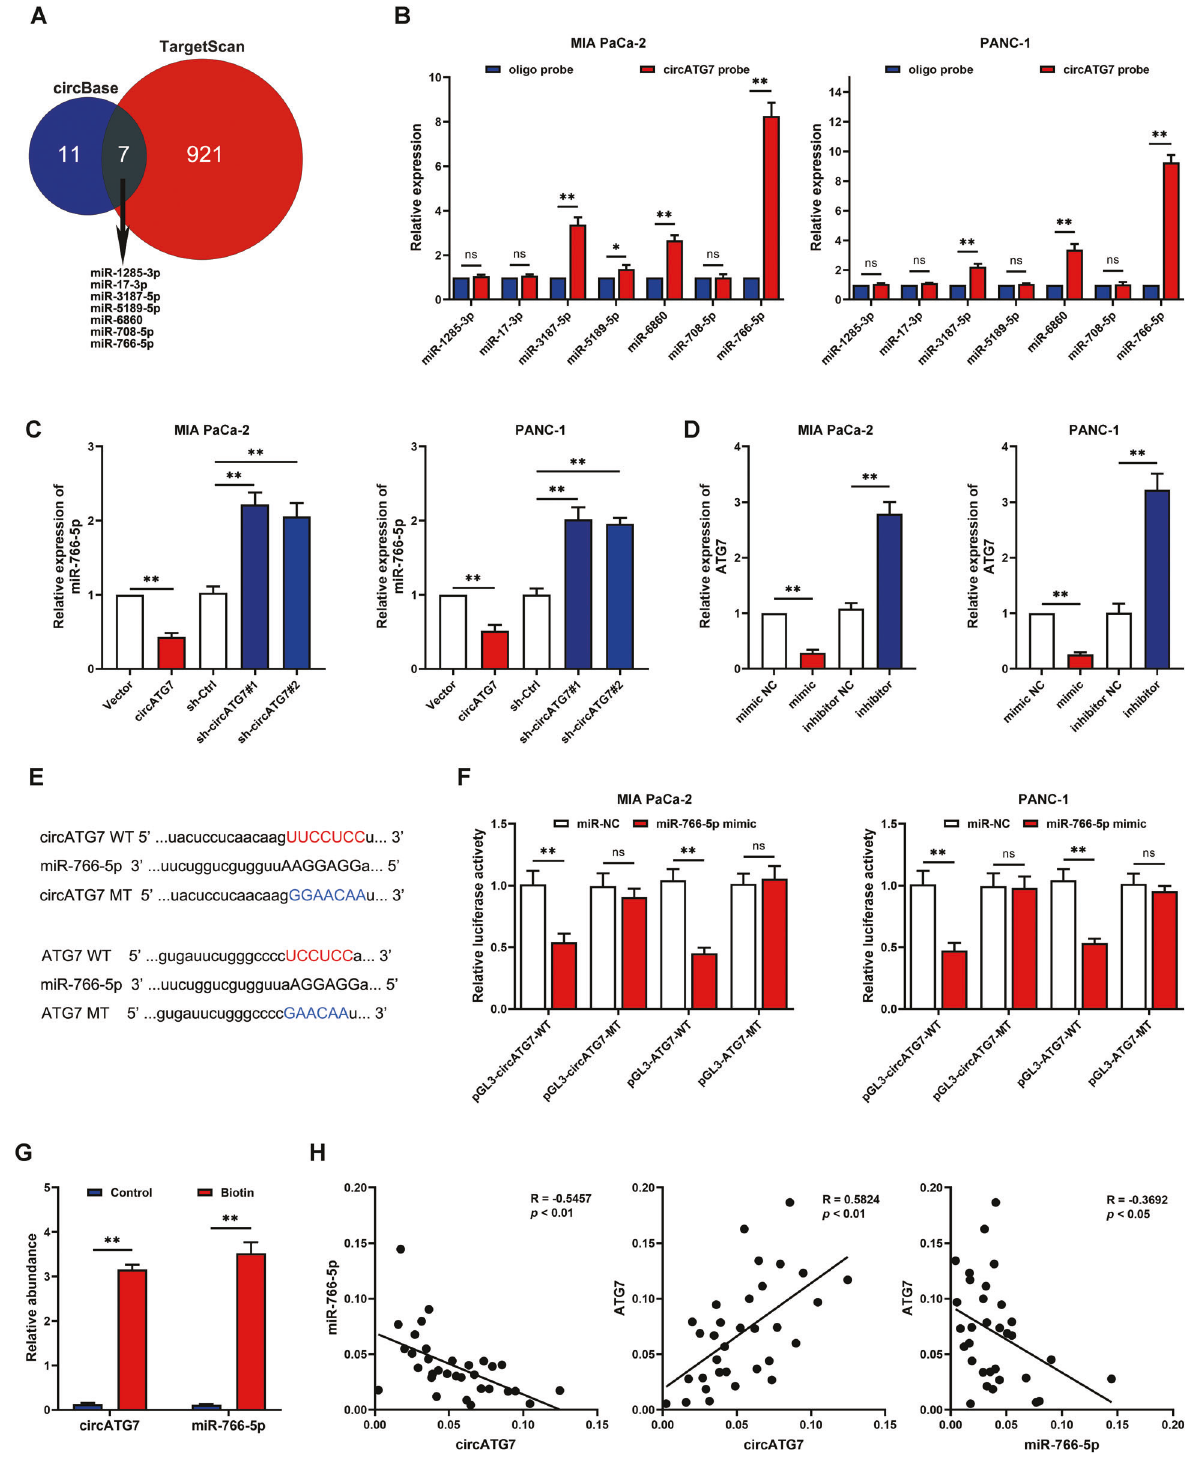
Fig. 5 Cytoplasmic circATG7 increased the mRNA level of ATG7 via sponging miR-766-5p. A CircBase and TargetScan were used in combination to analyze potential miRNAs regulated by circATG7 that can bind with ATG7. B CircATG7 probes were used to analyze the enrichment of miR-1285-3p, miR-17-3p, miR-3187-5p, miR-5189-5p, miR-6860, miR-708-5p, and miR-766-5p. C miR-766-5p expression was detected by RT-qPCR in PC cells with circATG7 gain or loss. D ATG7 expression was detected by RT-qPCR in PC cells with miR-766-5p gain or loss. E Binding sites between circATG7, miR-766-5p, and ATG7 are shown. F Luciferase activity assay was used to detect the binding between circATG7, miR-766-5p, and ATG7. G circATG7 was signi fi cantly enriched in the miR-766-5p probes. H RT-qPCR was used to evaluate the relationship between circATG7, miR-766-5p, and ATG7 expression. * P < 0.05; ** P < 0.01.